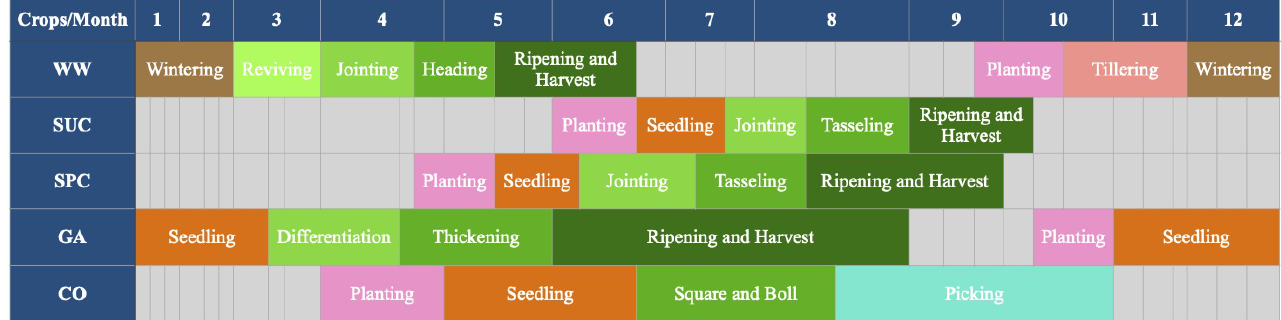
Figure 7. The phenological information of cropland and plastic-mulched land in Shandong province includes winter wheat (WW), summer corn (SUC), spring corn (SPC), garlic (GA) and cotton